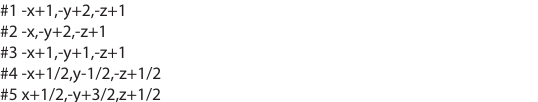
Table 2. MIC values (μg mL -1 ) of the promising thiourea derivatives against the tested fungi _______________________________________________________________ Compound